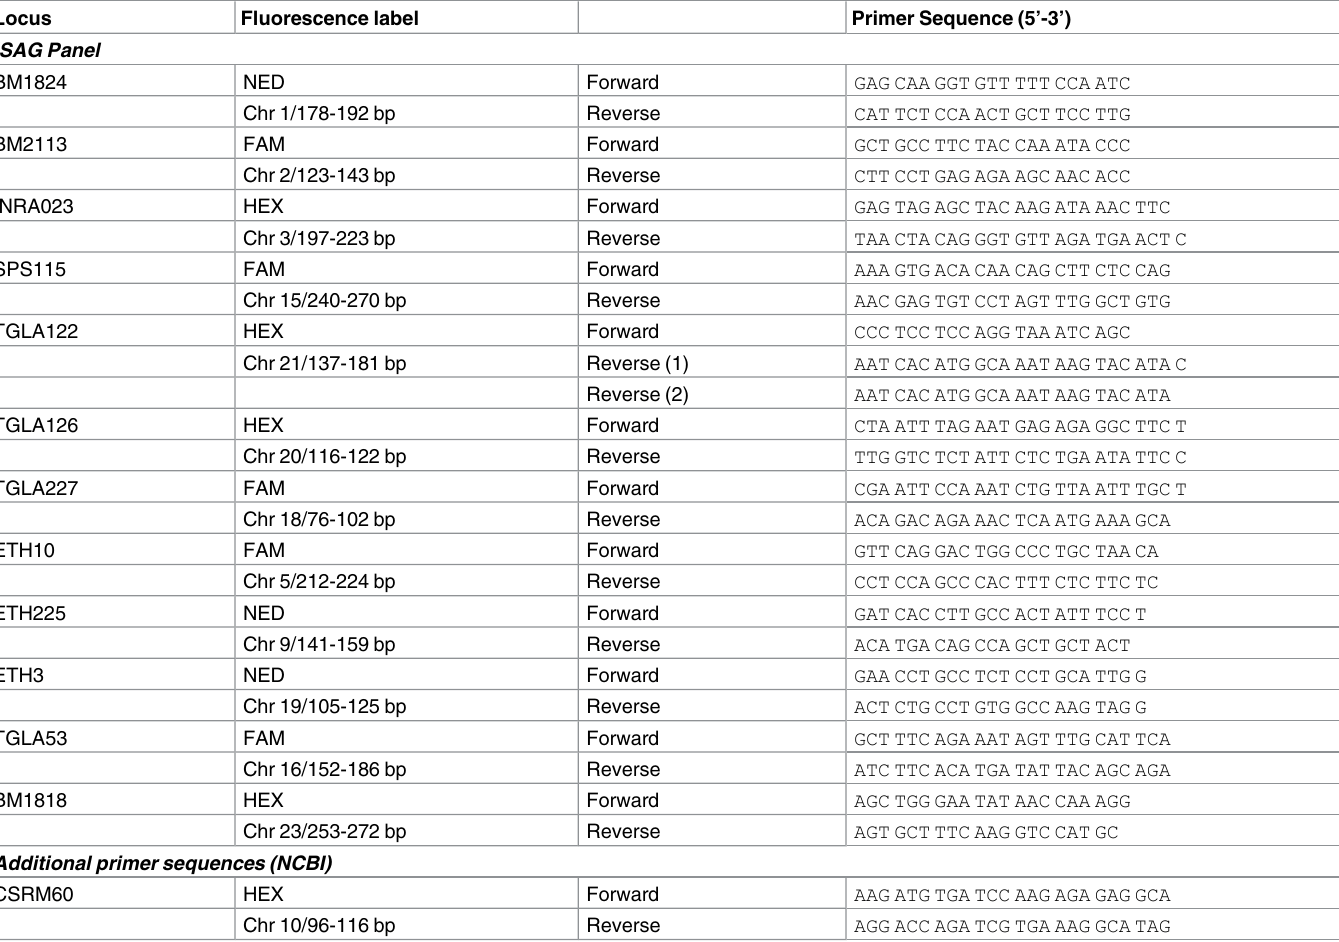
Table 2. Specific primer sequences used in the study (N = 13). Locus Fluorescence